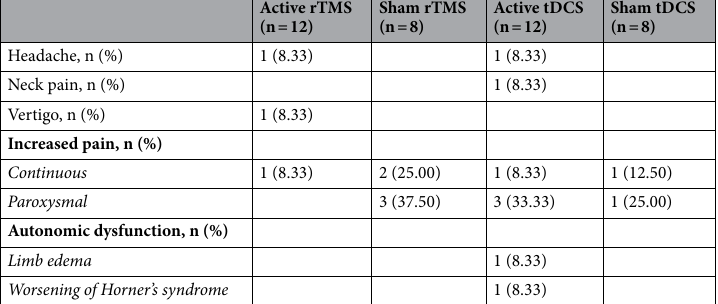
Table 2. Side effects observed after stimulation sessions. rTMS repetitive transcranial magnetic stimulation, tDCS transcranial direct-current